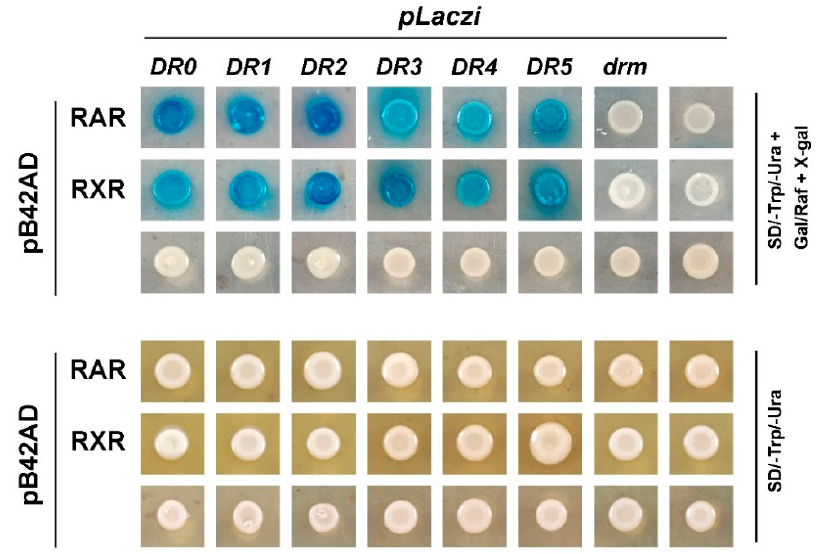
Figure 4. Cg RAR and Cg RXR bind DR0–DR5 in yeast. Both Cg RAR and Cg RXR can successfully bind the artificial triple repeated DR0 – DR5 sequences in yeast cells, whereas it did not bind to the drm sequence. Yeast stains co-transferred with fusion plasmids were grown on SD/-Trp/-Ura select medium ( lower rows) and were transferred to SD/-Trp/-Ura select medium with Gal/Raf and X-gal ( upper rows) to detect the activation of LacZ reporter gene.